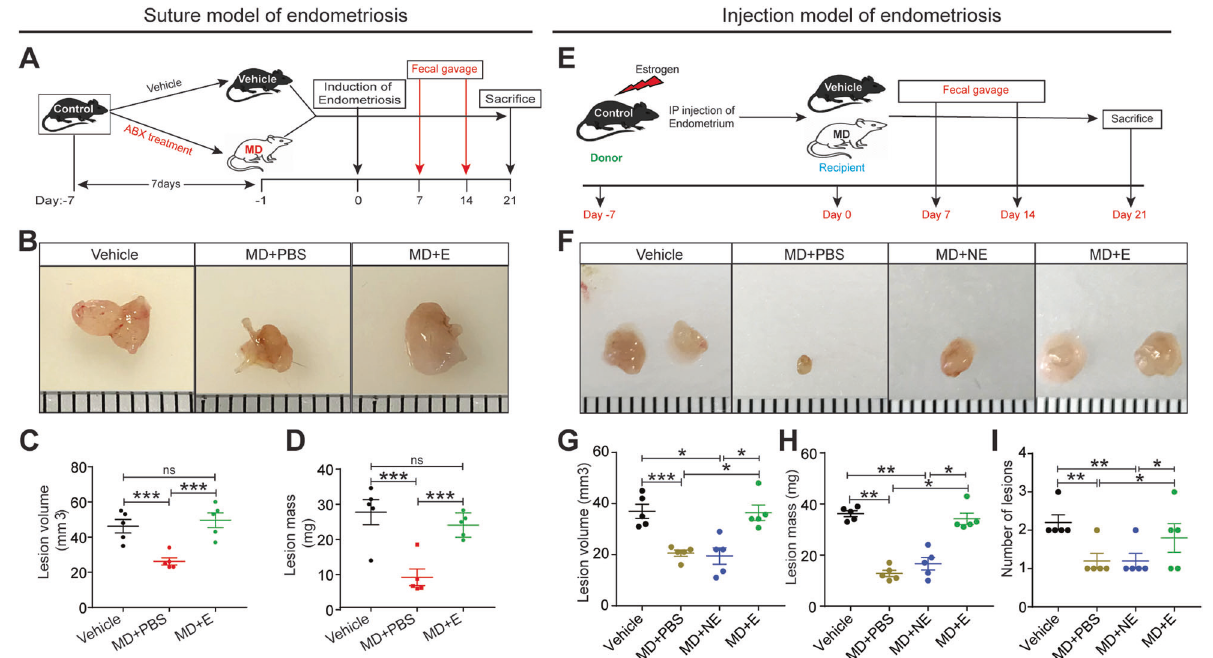
Fig. 3 Gut microbiota is required for endometriotic lesion growth in mice. A , E Schematic of experimental timeline and procedures for A suture model and E injection model for the fecal microbiota transfer (FMT) experiments. Microbiota-depleted mice underwent endometriosis induction and received an oral gavage of PBS (MD + PBS), feces from mice without endometriosis (MD + NE) or feces from mice with endometriosis (MD + E). B , F Ectopic endometriotic lesion representative images from B suture model and F injection model. C , G Ectopic lesion volumes from C suture model and G injection model. D , H Ectopic lesion masses from D suture model and H injection model from the indicated groups 21 days after the induction of endometriosis. I Number of lesions per mouse in injection model from the indicated